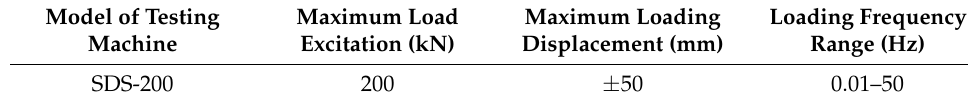
Table 4. Basic parameters of the dynamic testing machine.